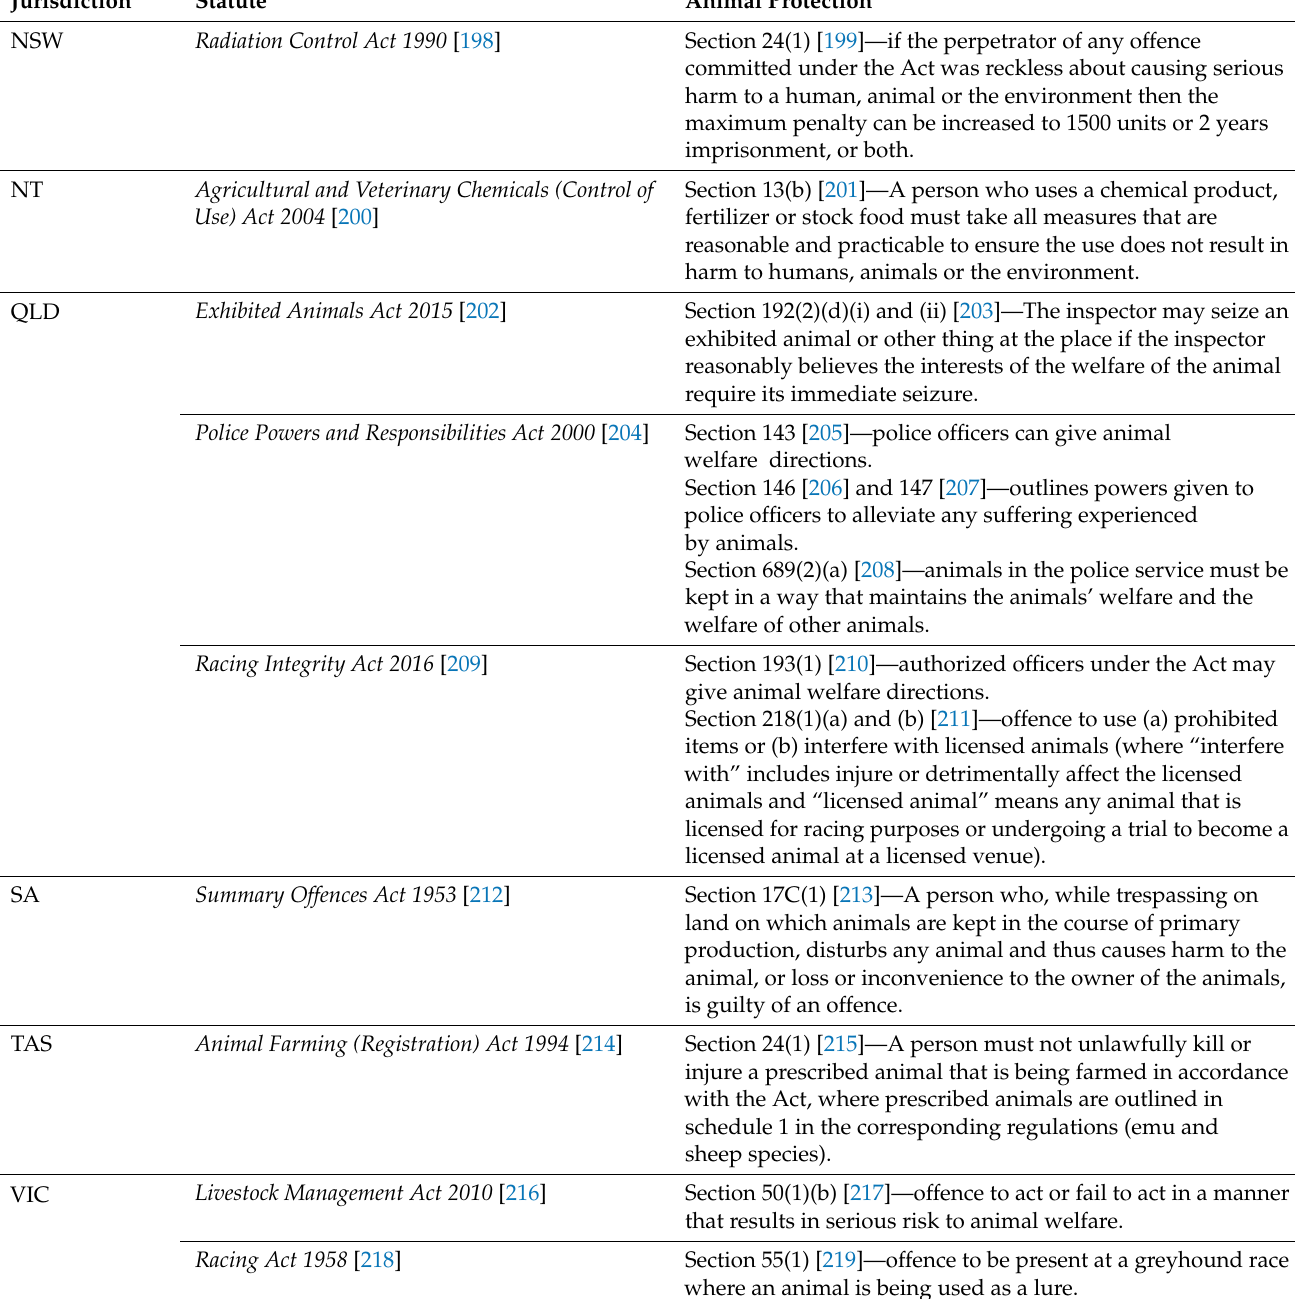
Table 13. Miscellaneous statutes with inclusions of animal protection provisions. These statutes can be further categorized into livestock, racing/sports, exhibited animals, chemical use, police powers and summary offences. ACT and WA are not included as no additional statutes that fit into this category were not sourced. Offences have been paraphrased for